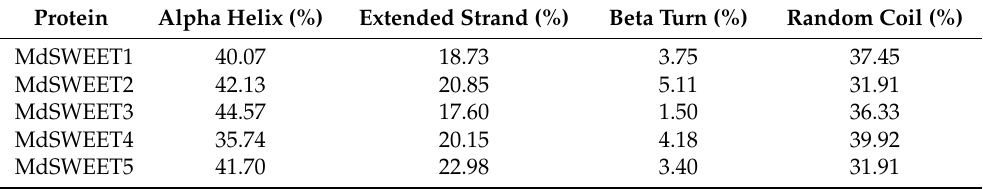
Table 2. Secondary structural statistics of MdSWEET proteins. The secondary structures were predicted based on the amino acid sequences using the SOPMA secondary structure prediction method (https://npsa-prabi.ibcp.fr/cgi-bin/npsa_automat.pl?page=npsa_%20sopma.html/ (accessed